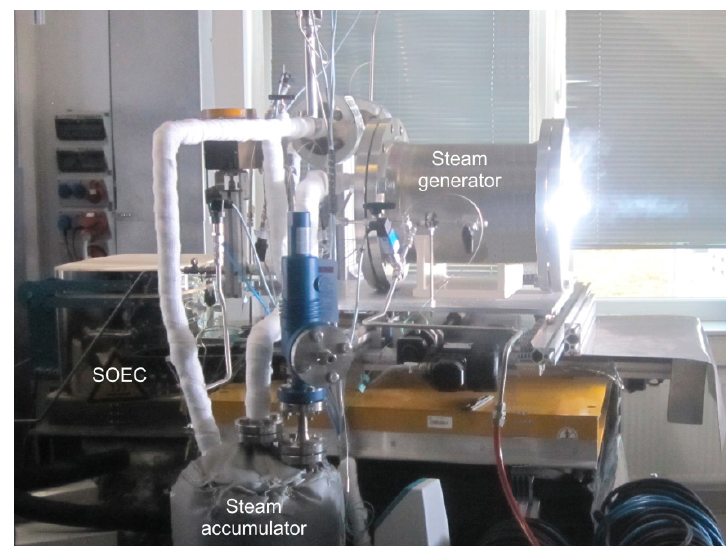
Figure 7. Setup of the system in operation according to [6].